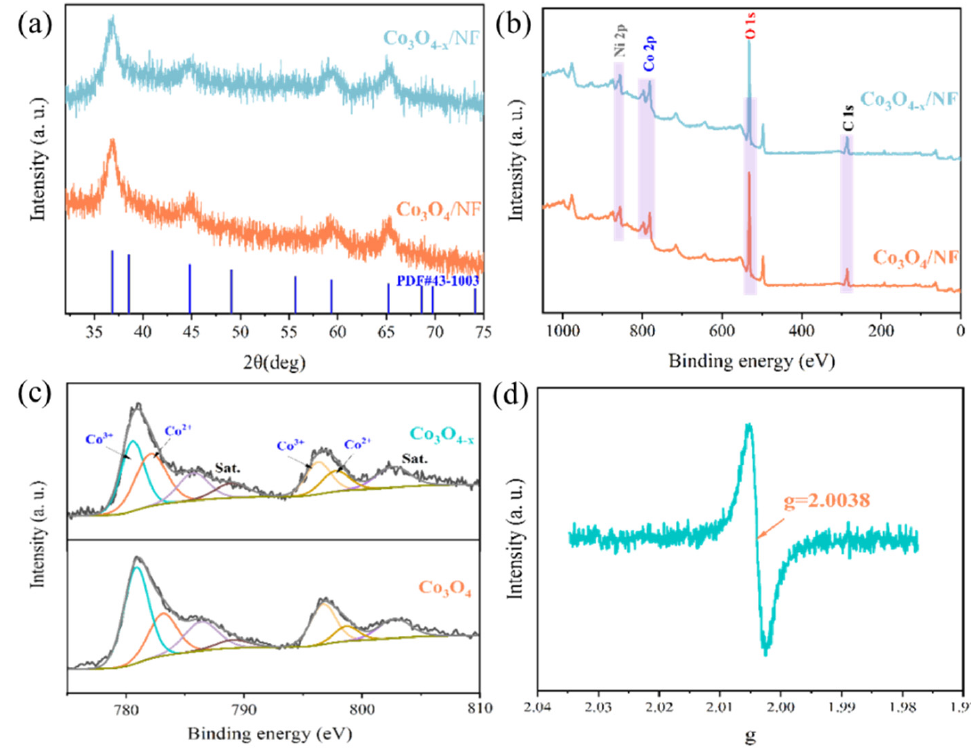
Figure 2. XRD pa tt erns of Co 3 O 4 /NF and Co 3 O 4-x /NF ( a ); XPS spectra of wide scan ( b ) and Co 2p ( c ); Figure 2. XRD patterns of Co 3 O 4 /NF and Co 3 O 4 − x /NF ( a ); XPS spectra of wide scan ( b ) and Co 2p value of Co 3 O 4-x /NF (in g) ( d ). ( c ); value of Co 3 O 4 − x /NF (in g) ( d